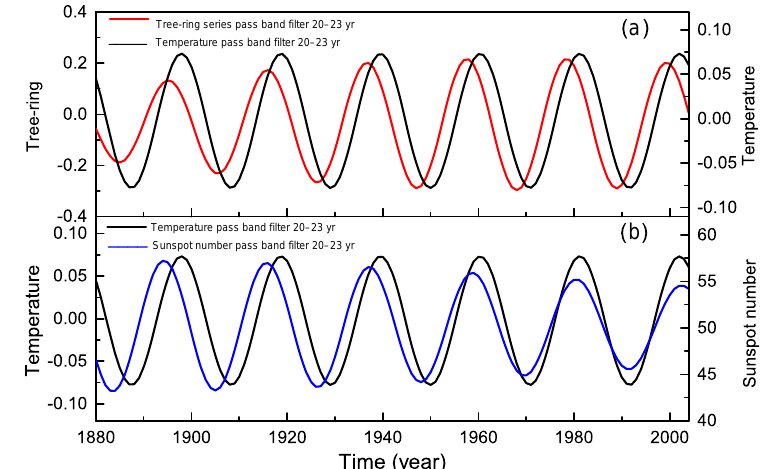
Figure 7. (a) Signals filtered of the mean width of tree-ring series and annual mean temperature anomaly (from 24 to 44 ◦ S); (b) annual mean temperature anomaly (from 24 to 44 ◦ S) and sunspot number, between 20 and 23 years.